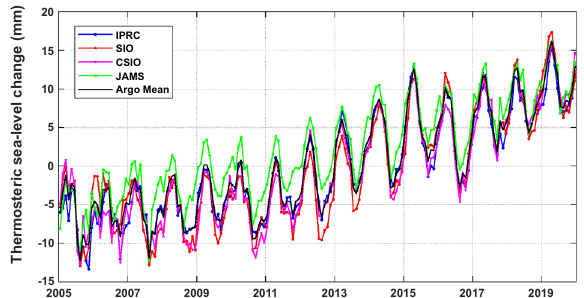
Figure 3. The global mean thermosteric sea-level change derived from four Argo products. The ensemble mean of four components is displayed as a black line.